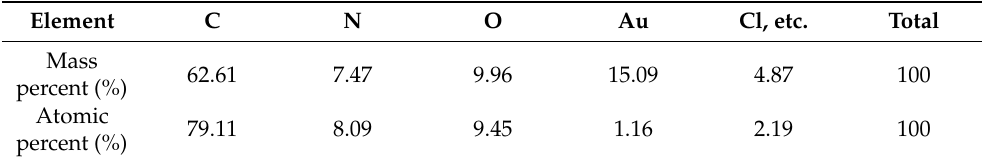
Table 2. EDS results of one microdomain containing Au nanoparticle in PANi/Au nanocomposite containing